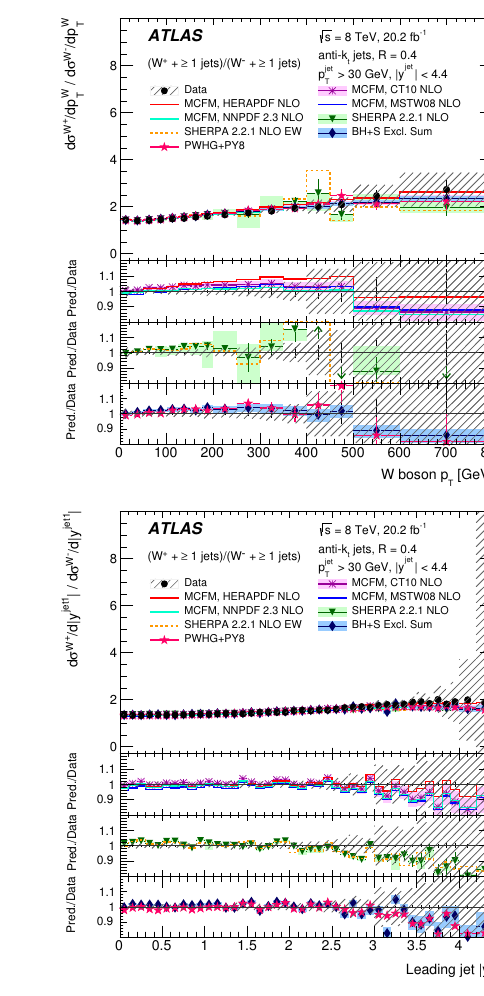
Figure 7 . W + to W (cid:0) cross-section ratio as a function of H T (top left), W p T (top right), leading jet p T (bottom left) and leading jet rapidity (bottom right) for events with N jets (cid:21) 1. For the data, the statistical uncertainties are indicated as vertical bars, and the combined statistical and systematic uncertainties are shown by the hatched bands. The uppermost panel in each plot shows the di(cid:11)erential cross sections, while the lower panels show the ratios of the predictions to the data. The theoretical uncertainties on the predictions are described in the text. The arrows on the lower panels indicate points that are outside the displayed